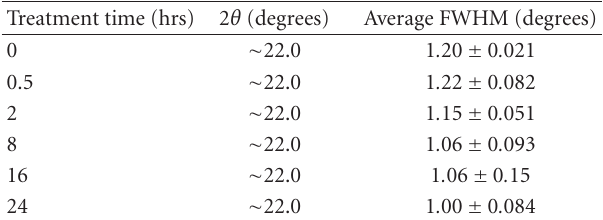
Table 2: E ff ect of time on FWHM in kenaf